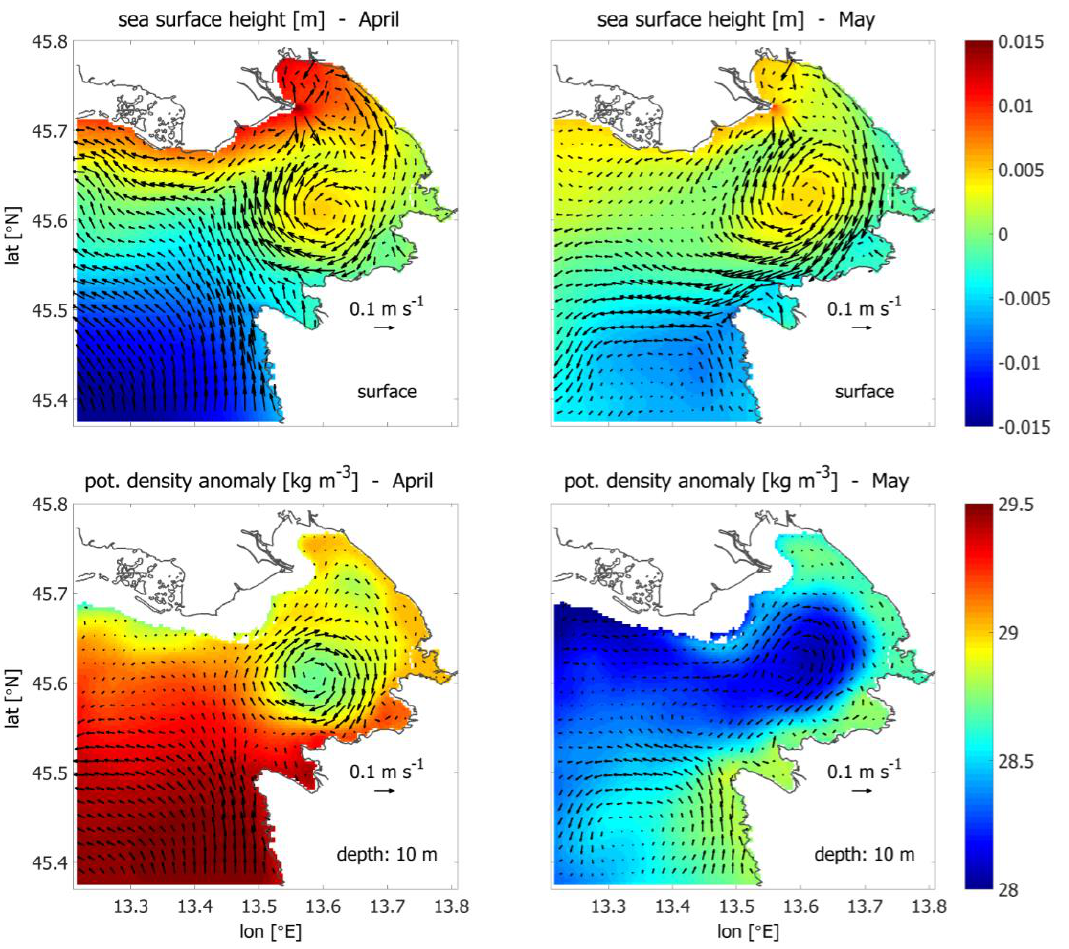
Figure 13. Modelled monthly averaged sea surface height and velocity ( top panels ) and potential density anomaly and velocity at 10 m depth ( bottom panels ) in April ( left ) and May ( right ) 2012. velocity at 10 m depth ( bottom panels ) in April ( left ) and May ( right )